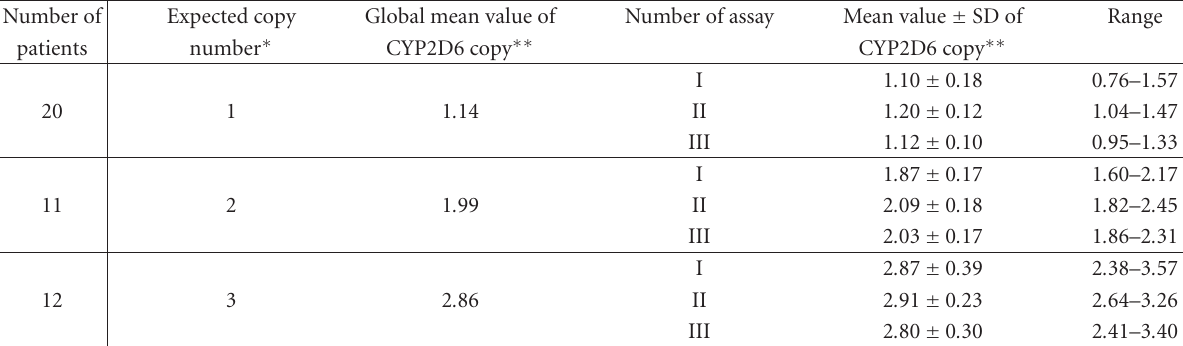
Table 2. Global analysis of CYP2D6 gene quantification based on three independent experiments. The analysis of gene copy number was performed using the formula 2 ∗ 2 − ∆∆ Ct+ / − SD . SD stands for standard deviation and CV coe ffi cient of variation. The three groups are significantly di ff erent with P < . 05 (Mann-Whitney U test). Means are obtained from the averages of the final results of each run after 2 ∗ 2 − ∆∆ Ct+ / − SD calculation. The borderlines are well delimited in I, II, and III. Means are given by the averages of the results from each group. Range is defined by the lower and upper limits for each group. SD is the average of sd of the mean of the triplicate.